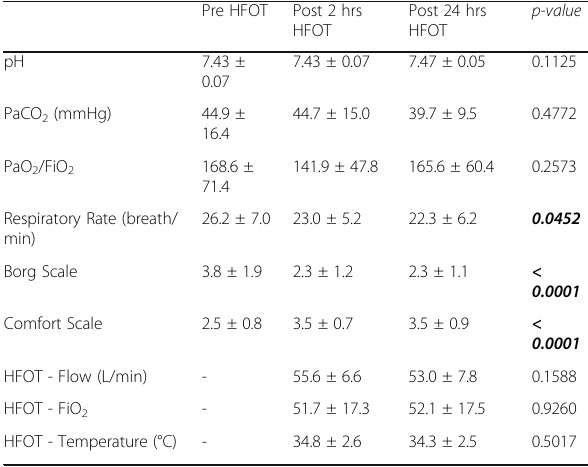
Table 1 (abstract 0426). Data are reported as mean ± SD. one-way ANOVA for repeated measurement with a post hoc Tukey's correction was